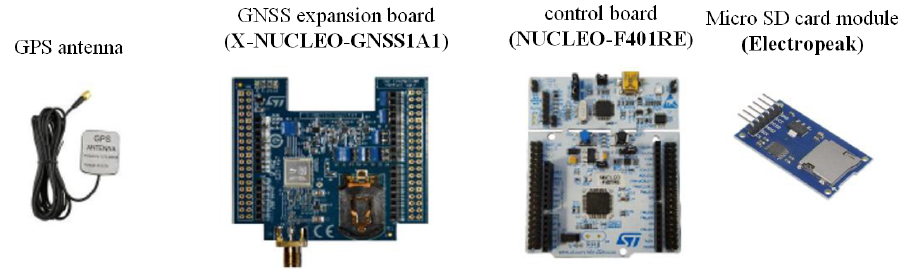
Figure 5. Components adopted for the control node in field